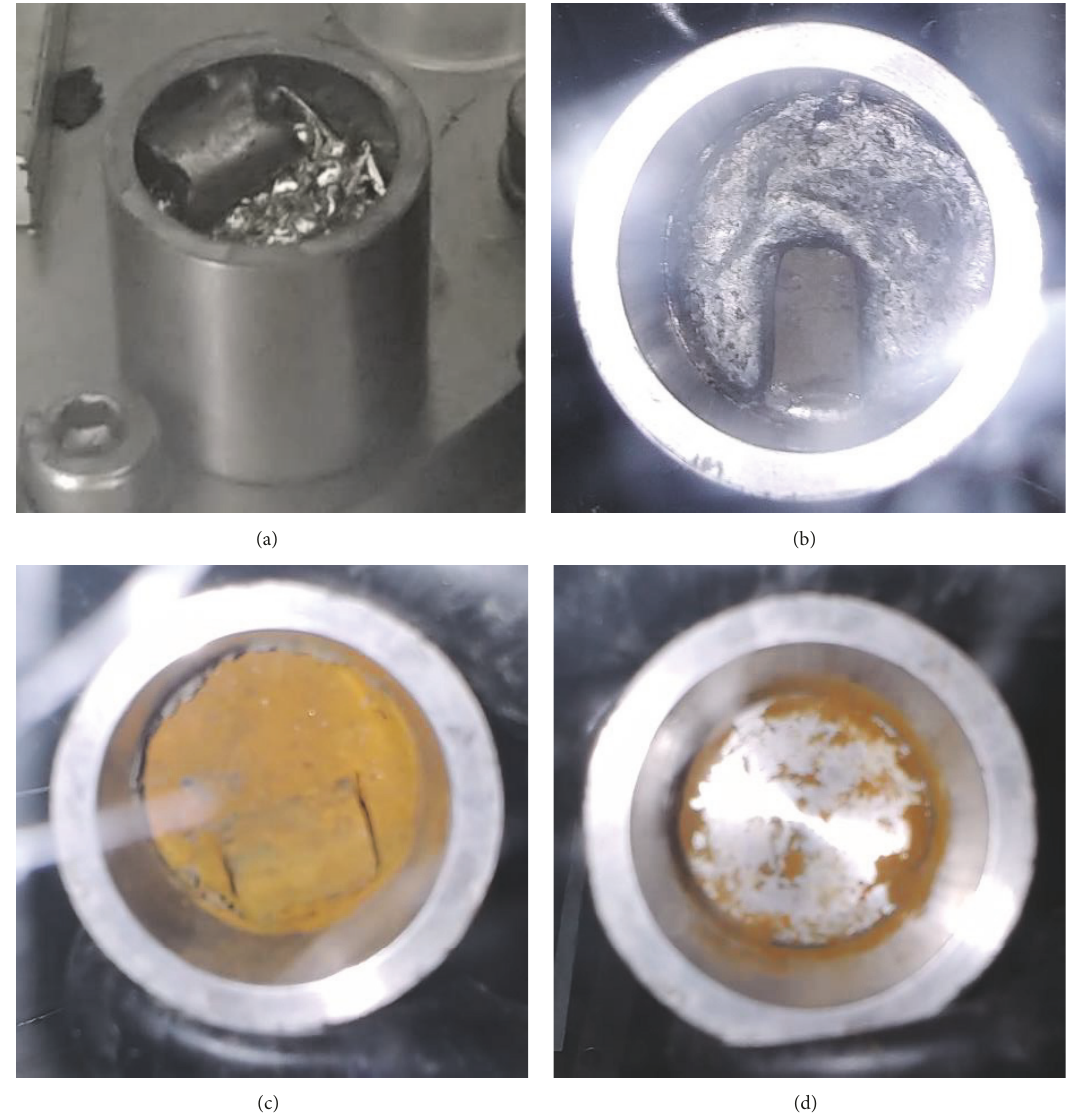
Figure 5: Images of the W crucible before and after the distillation test: (a) W crucible loaded with U and Cd was loaded, (b) after fabrication of U–Cd alloy, (c) after Cd distillation test, and (d) after dumping of the